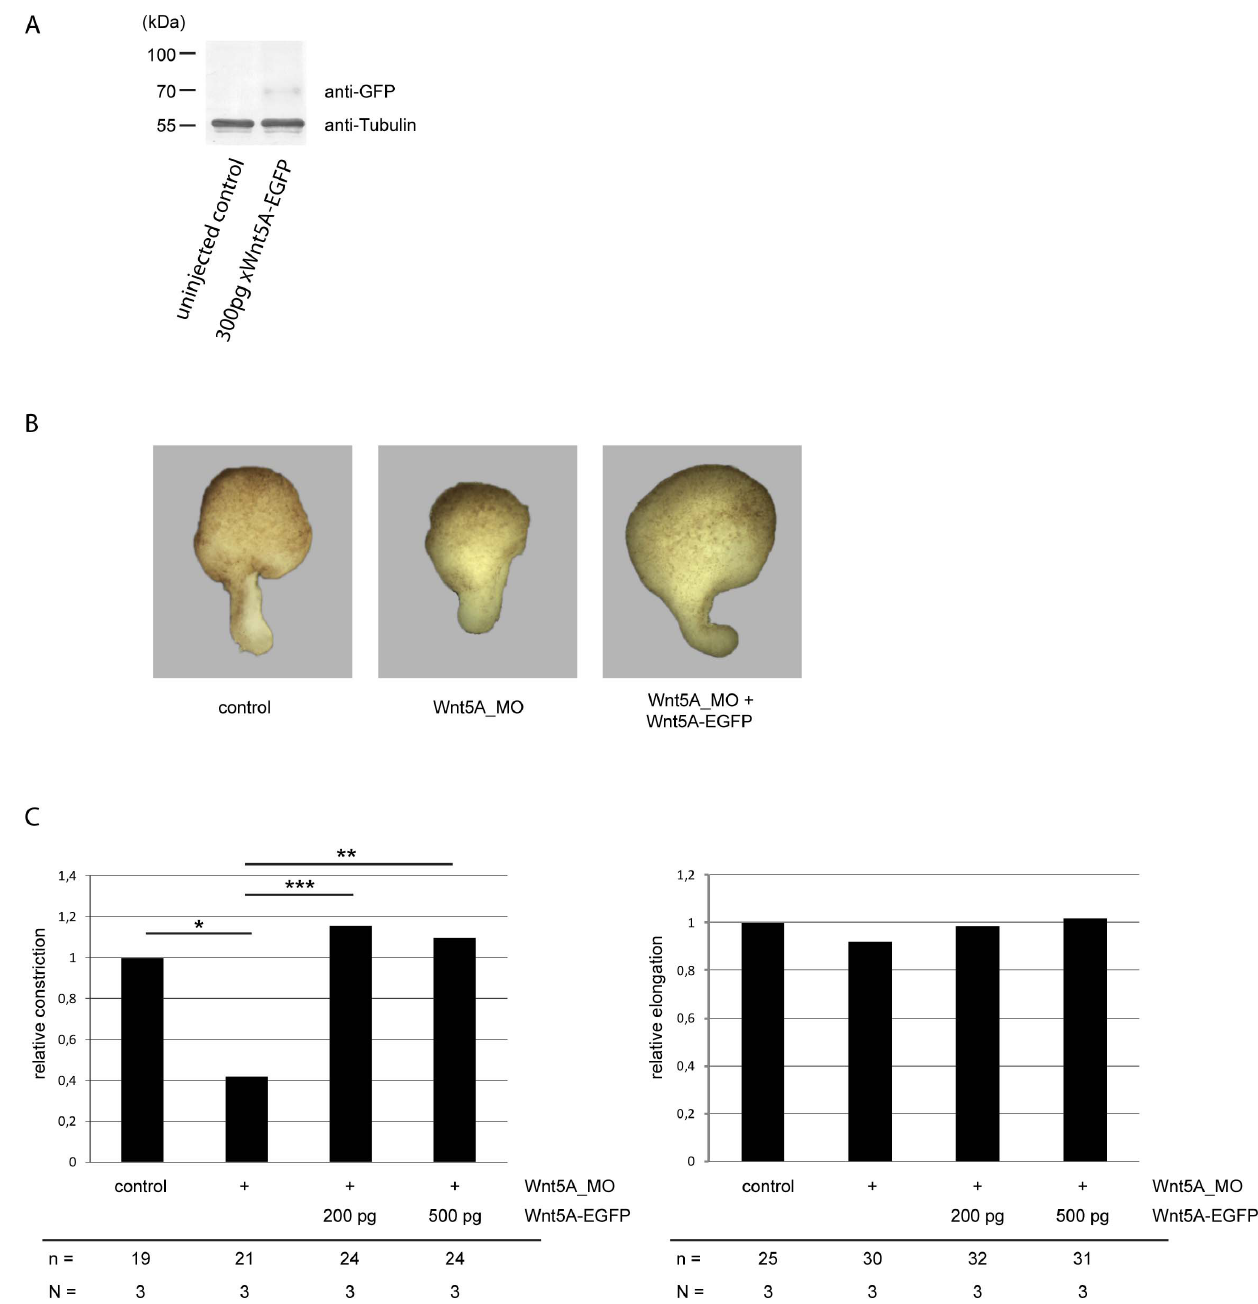
Figure 1. Xwnt5A-EGFP can compensate for the loss of endogenous Xwnt5A. A) An anti-EGFP reactive protein of the expected size is produced by embryos injected with Xwnt5A-EGFP. 300 pg Xwnt5A-EGFP mRNA were injected into each blastomere of two-cell stage embryos. NOP lysates corresponding to one half embryo were separated on an 8% SDS PAGE, transferred onto nitrocellulose and incubated with an anti-EGFP and anti-tubulin antibody. B) 1.6 pmol Xwnt5A morpholino (5AMo) were injected together with the indicated amounts of Xwnt5A-EGFP mRNA in the two dorsal blastomeres of eight-cell stage embryos. At stage 10.25, dorsal marginal zones were explanted and analyzed for convergence and extension. C) Quantification of elongation and constriction phenotypes. Given is the portion of embryos with impaired constriction (left image) and impaired elongation (right image) of Xwnt5A morphants (Wnt5A_Mo) and morphants co-injected with the indicated amount of Xwnt5A-EGFP mRNA. N: number of independent experiments, n: number of analyzed explants. *: p , 0.05, **: p , 0.01, ***: p , 0.001 according to Fisher’s exact test. fluorescence cross-correlation spectroscopy (FCCS). Fluorescence amplitude if two fluorescent particles diffuse as an entity, i.e., if fluctuations from two spectral channels are cross-correlated ([18], they are bound to each other. and the cross-correlation function has only an appreciable The static FCS approach is not easily applicable for measuring receptor-ligand interactions in cell membranes. Membrane